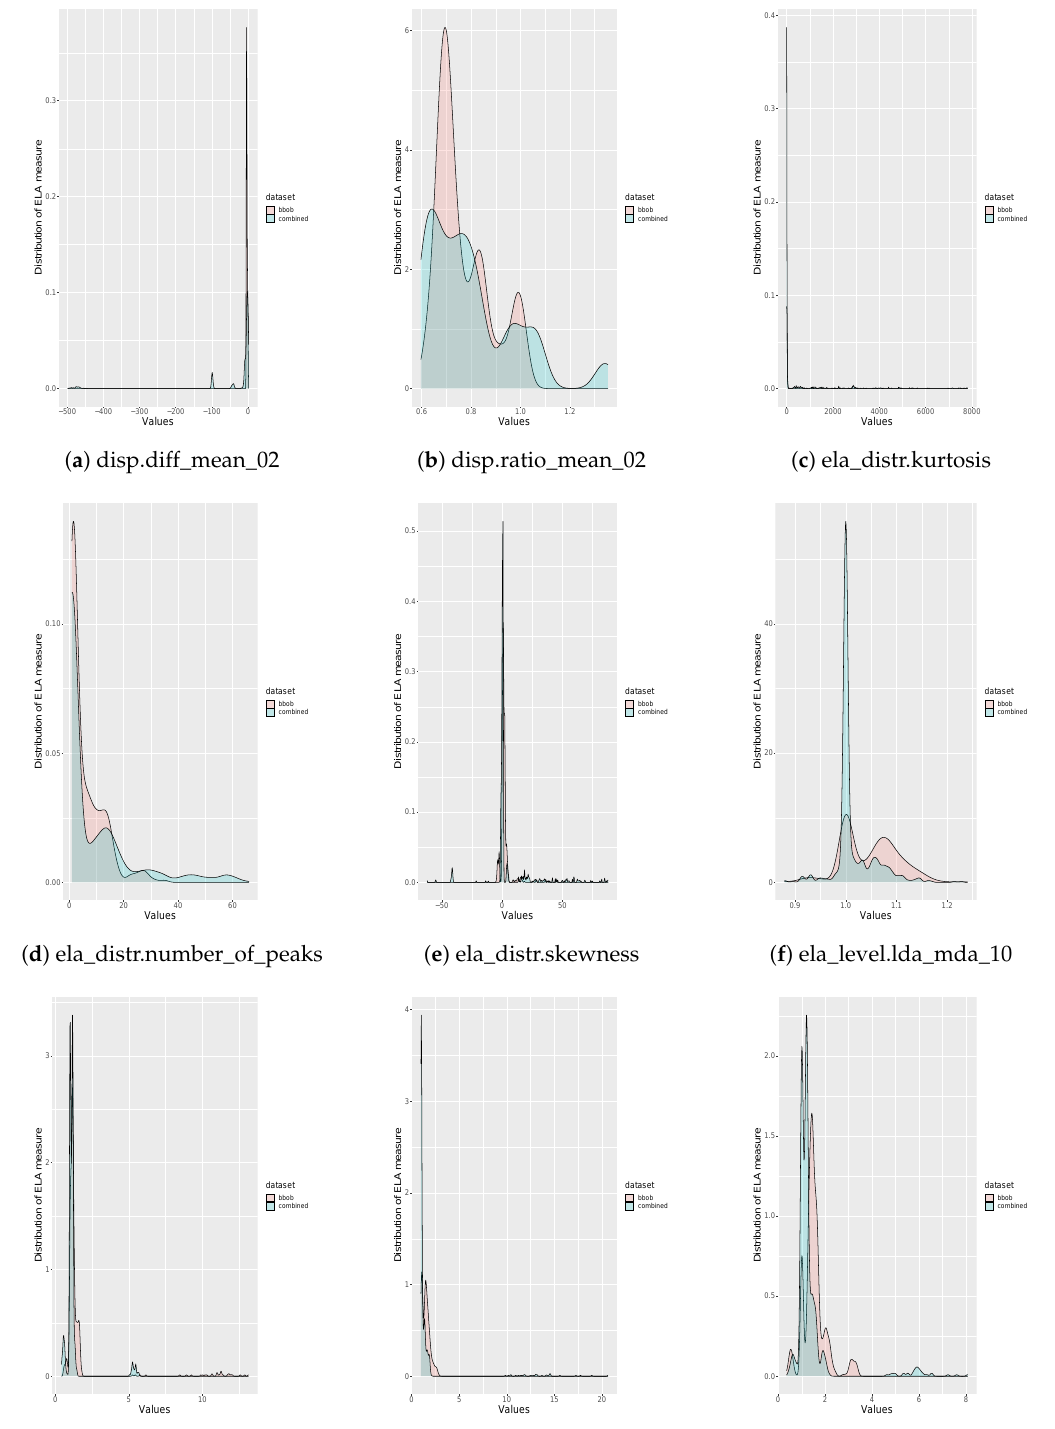
Figure 7. Comparison of the distributions of the BBOB benchmark suite and the proposed benchmark suite for all of the ELA measures used as input to the